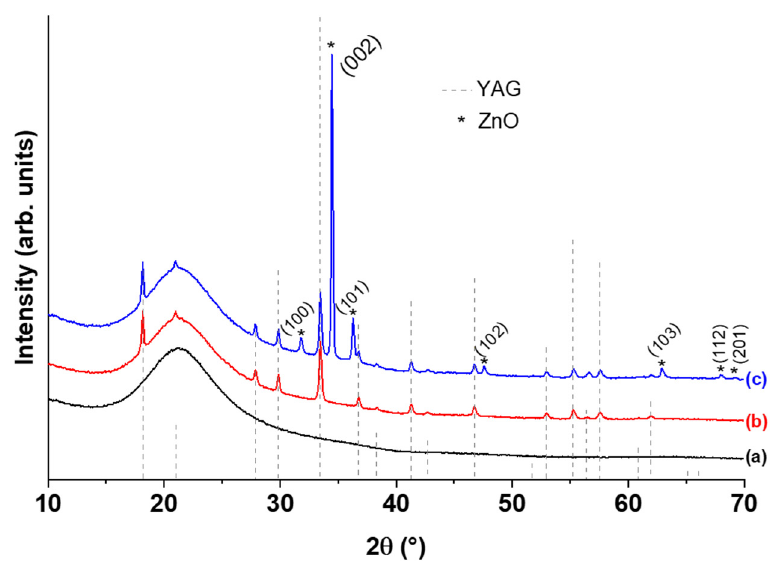
Figure 1. XRD patterns of ( a ) silica substrate, ( b ) YAG:Ce coating alone and ( c ) YAG:Ce/ZnO NWs heterostructure.